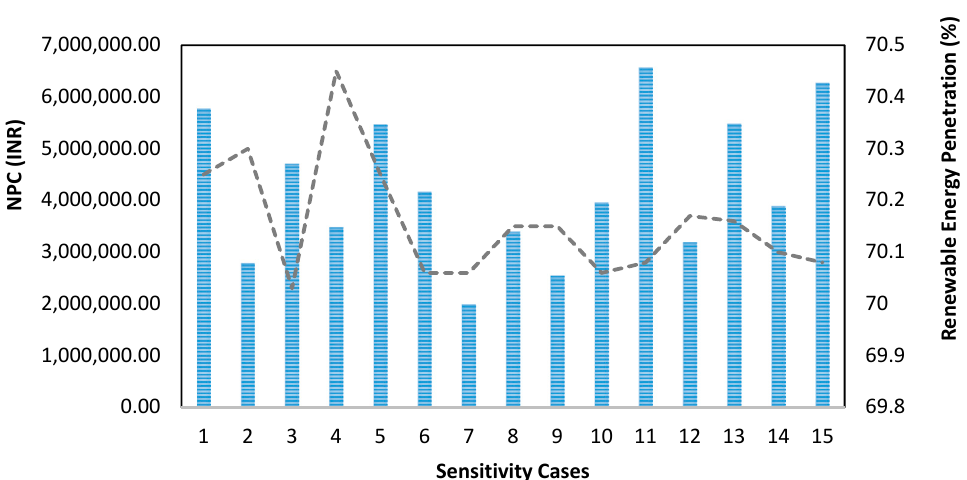
Figure 12. NPC and RE penetration for different sensitive cases.